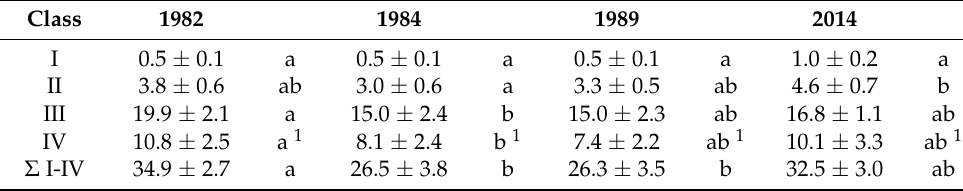
Table 3. Mean BA of trees in classes (m 2 /ha) ( ± standard error) in four survey years. Significant differences in the mean basal area according to different years are marked with different letters based on the Friedman test with significance p < 0.05. Letter meaning is the same as in Table